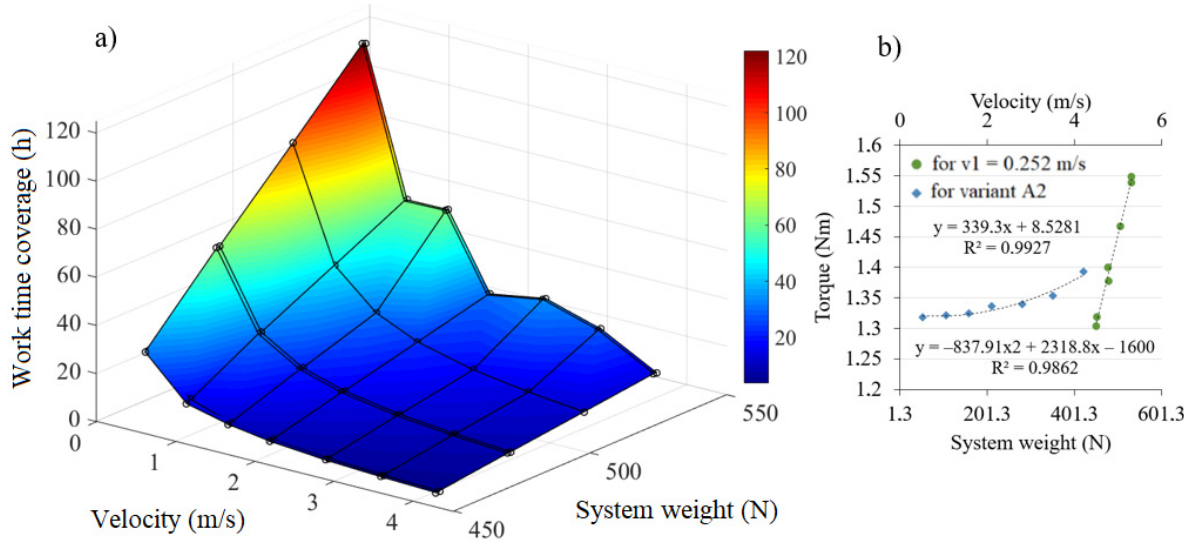
Figure 9. Demand for: ( a ) work time coverage, ( b ) drive torque depending on the wheelchair velocity and the weight of the system.